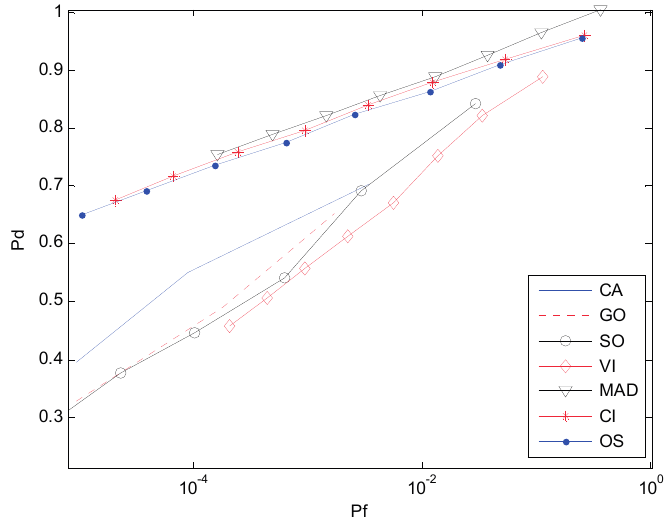
Figure 8. P vs . P (ROC) in the non-homogenous environment with one interference in d f each half of the reference window,